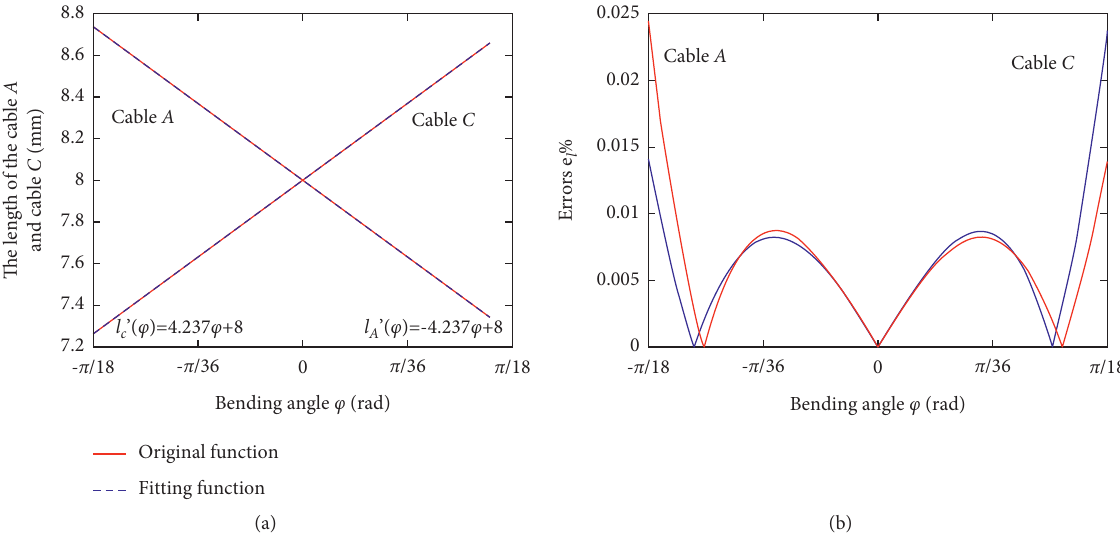
Figure 10: Cable A and cable C error between the original and fitted function. (a) Bending angle φ (rad). (b) Bending angle θ